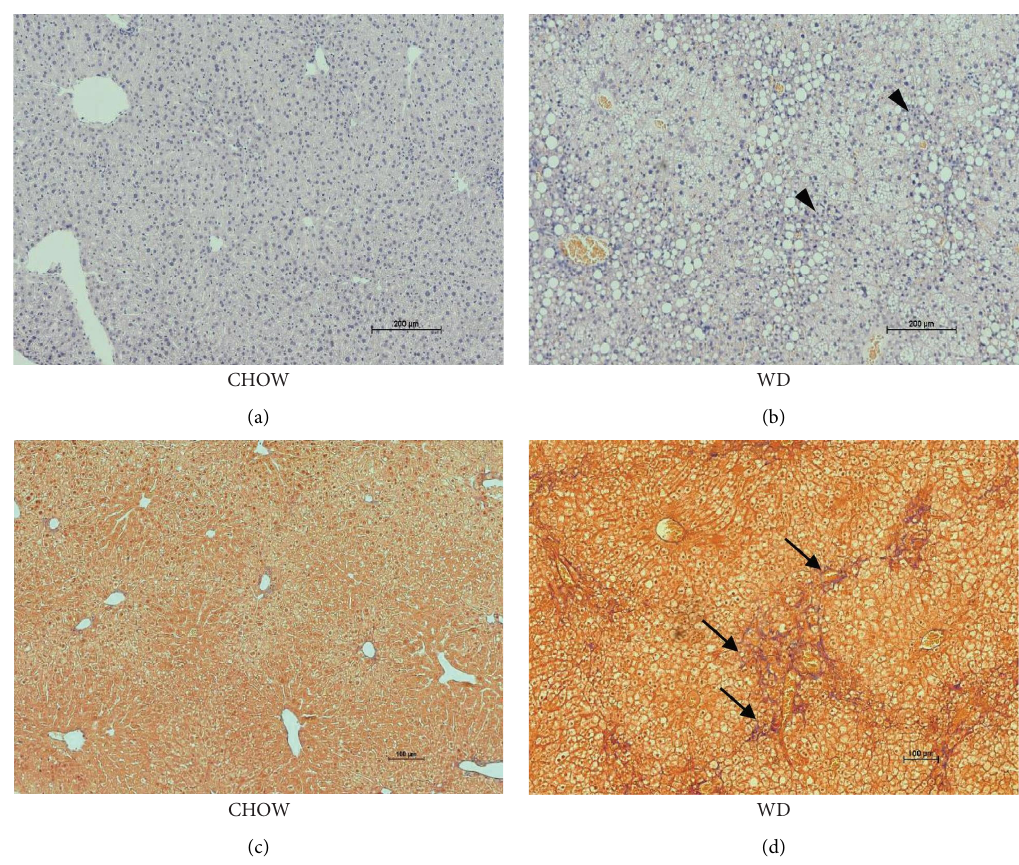
Figure 1: Prolonged Western diet (WD) induces hepatic steatosis in male LDLr − / − ApoB 100/100 mice. LDLr − / − ApoB 100/100 male mice were fed the WD for 5 months. When detecting hepatic steatosis, liver sections were stained with hematoxylin-eosin (a) on a chow diet and (b) after 5months on the WD. When determining liver fbrosis, liver sections (c) on a chow and (d) after the WD was stained with Masson trichrome stain that designates fbrosis with blue color (arrow). Te WD induced high increase in hepatic lipid accumulation and infltration of infammatory cells (arrowhead) and promoted liver fbrosis. Representative pictures of livers are shown with a scale bar 200 μ